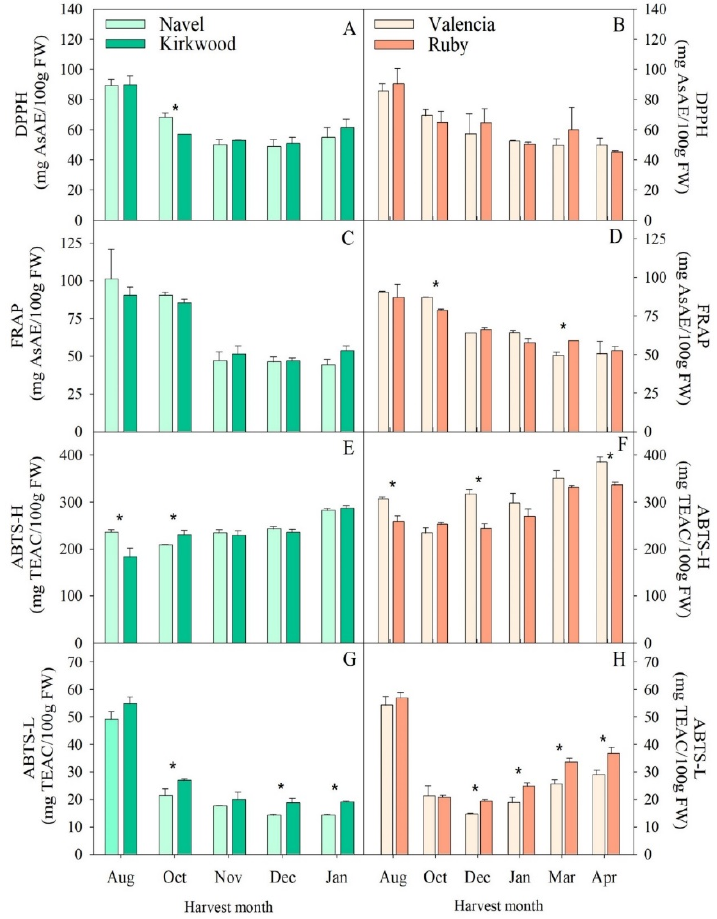
Figure 5. Evolution of the antioxidant capacity, evaluated by DPPH ( A , B ), FRAP ( C , D ), ABTS-H ( E , F ) and ABTS-L ( G , H ) assays, in the pulps of Navel and Kirkwood ( left panel ) and Valencia and Ruby ( right panel ) oranges during late fruit development and maturation. Results are the mean of two biological replicates ± SD. Asterisks indicate significant differences between the red-fleshed K and R and the respective ordinary oranges, N and V, for each harvest month by t -test ( p ≤ 0.05). The ABTS-L showed a significant positive Pearson’s correlation with the concentra- tion of tocopherols (r 2 = 0.85) (Table S2). Tocopherols are efficient ROS scavengers and, DPPH (r 2 = 0.79) and FRAP (r 2 = 0.67). Moreover, the total phenolic and flavonoid